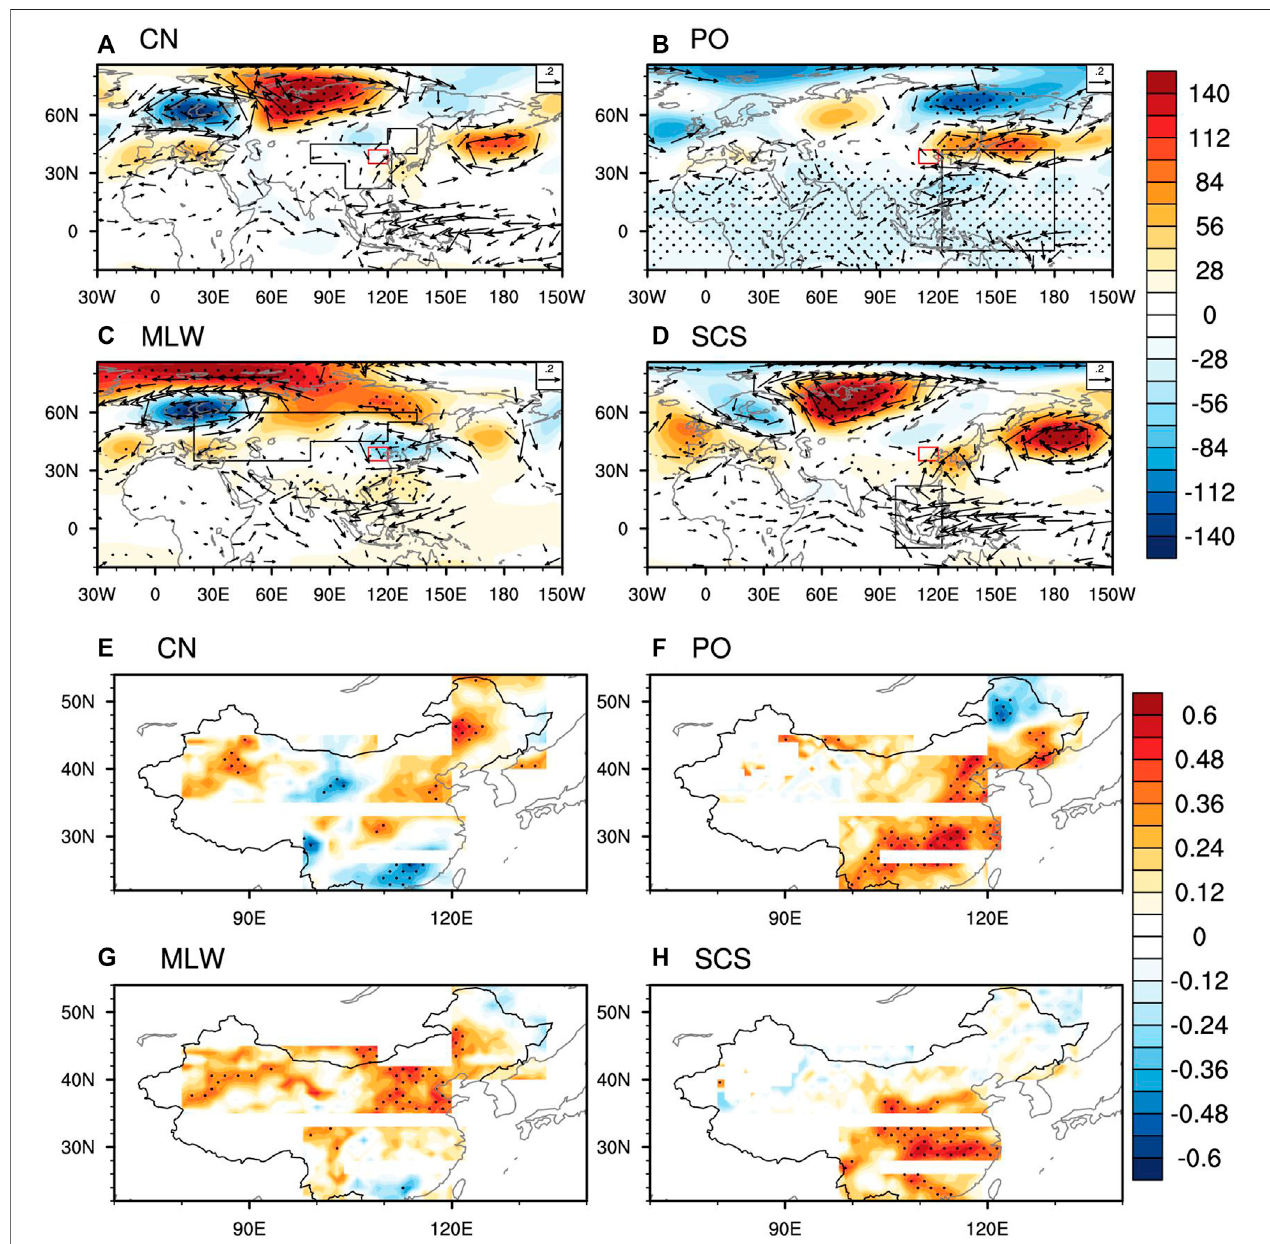
FIGURE 6 | As in Figure 5 but for NC. Panels (A – D) show circulation anomalies regressed against the CN, PO, MLW and SCS moisture sources. Panels (E – H) show the CN and MLW source precipitation anomalies correlated with the high-latitude wave train index, the PO source with the PJ index, and the SCS source with the WNPSH